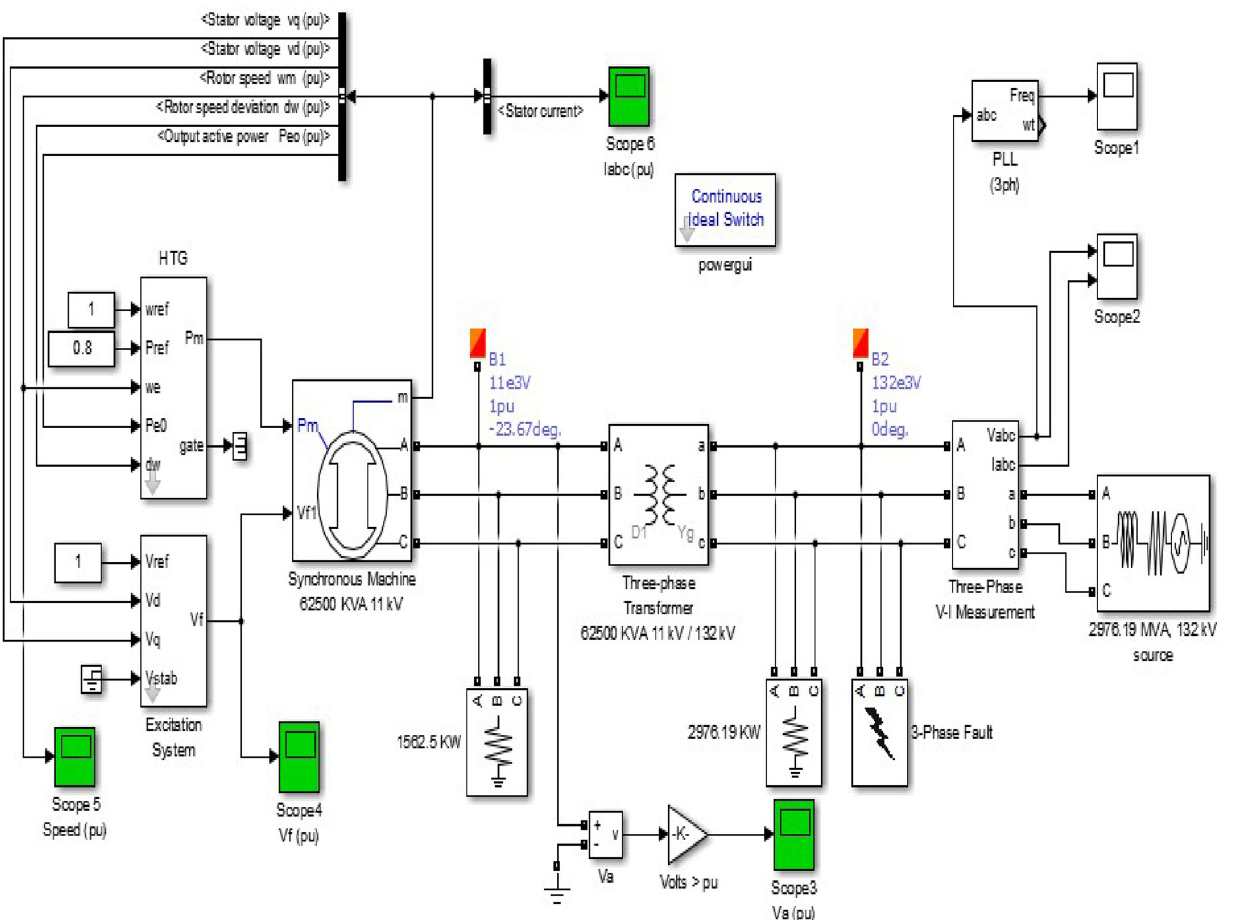
Fig 5. Simulation of Karnafuli Hydroelectric Power Station